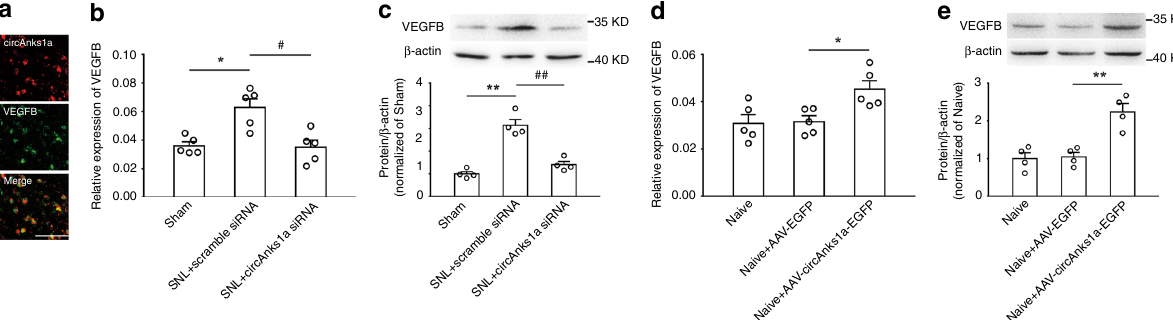
Fig. 5 Upregulation of VEGFB was dependent on circAnks1a expression following SNL. a Colocalization of circAnks1a and VEGFB. Scale bar, 50 μ m ( n = 3). b , c Intrathecal injection of circAnks1a siRNA decreased the mRNA and protein expression of VEGFB in the spinal dorsal horn of rats on day 14 following SNL ( * P < 0.05, ** P < 0.01 vs. sham group, # P < 0.05, ## P < 0.01 vs. the corresponding scramble group, two-tailed one-way ANOVA, n = 5 for ( b ) and n = 4 for ( c )). d , e Twenty-one days following intraspinal injection of recombinant AAV-circAnks1a-EGFP, the expression of VEGFB was signi fi cantly upregulated at mRNA and protein levels ( * P < 0.05, ** P < 0.01 vs. the AAV-EGFP group, two-tailed one-way ANOVA, n = 5 for ( d ) and n = 4 for ( e )). The data are presented as the mean ± s.e.m. Source data are available as a Source Data fi